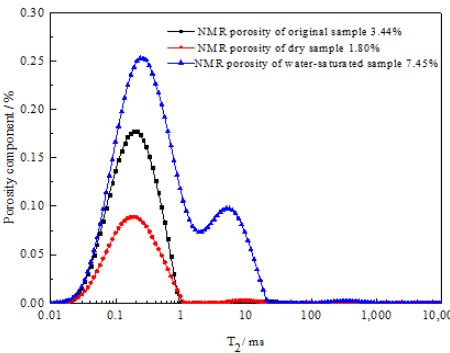
Figure 5. Shale NMR at 2 MHz.